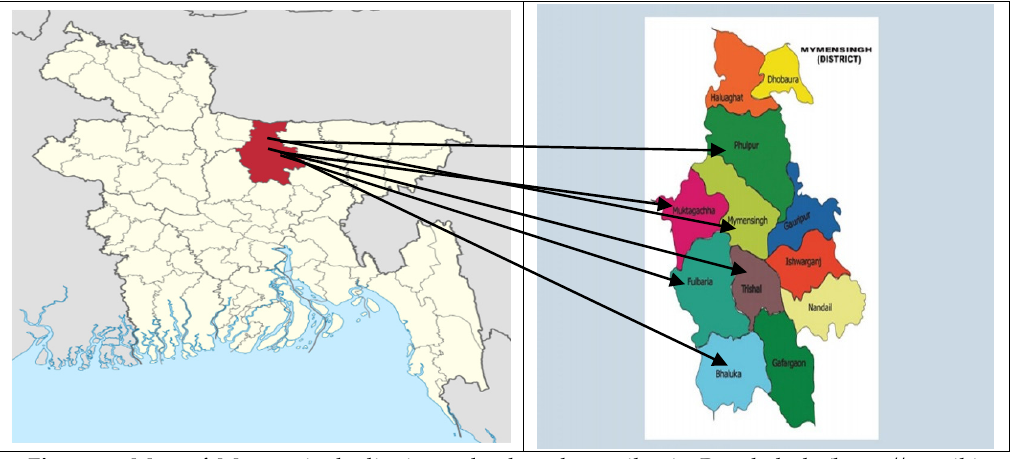
Figure 2. Map of Mymensingh district and selected upazilas in Bangladesh (https://en.wikipe- dia.org/wiki/Mymensingh_District (accessed on 24 November 2021)).